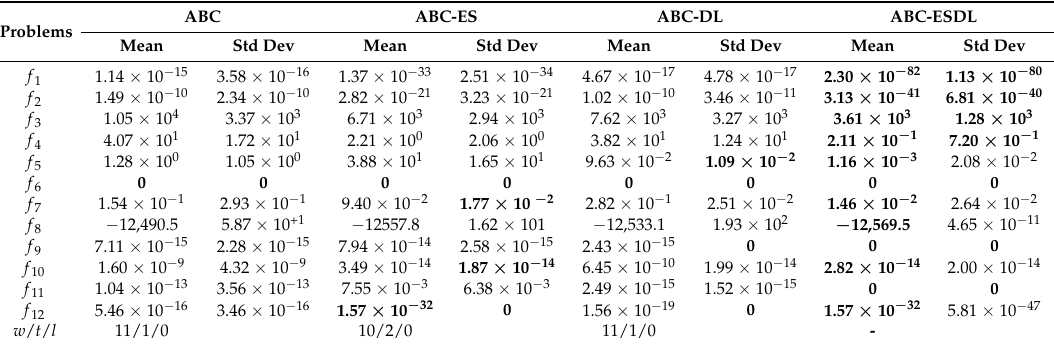
Table 5. Comparison of ABC with different strategies ( D =